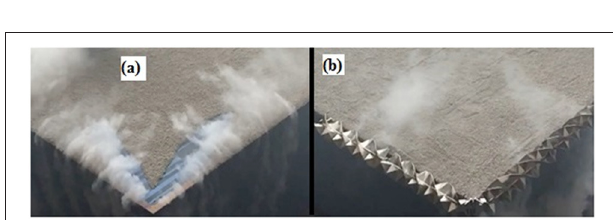
FIGURE 5 | (A) Bare roof (without turbine); (B) turbine attached to the roof